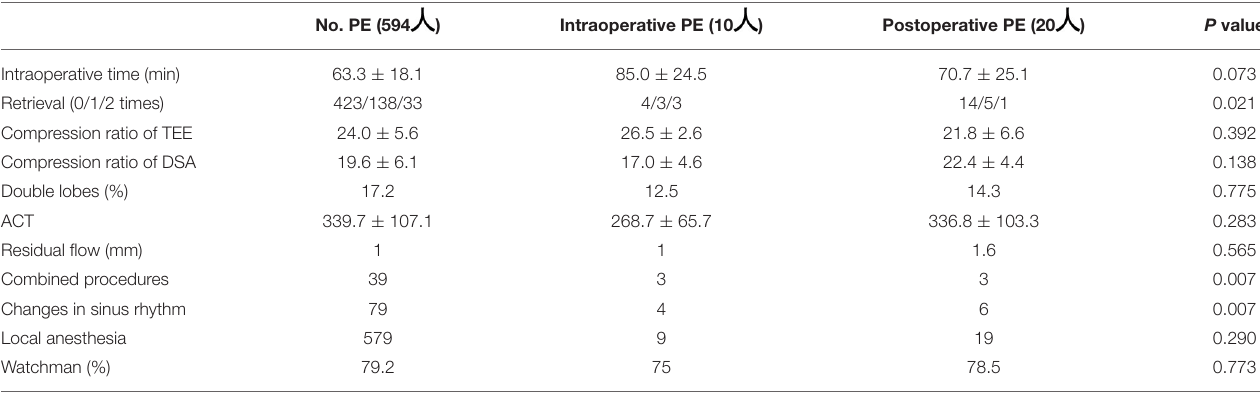
ACT, activated clotting time.